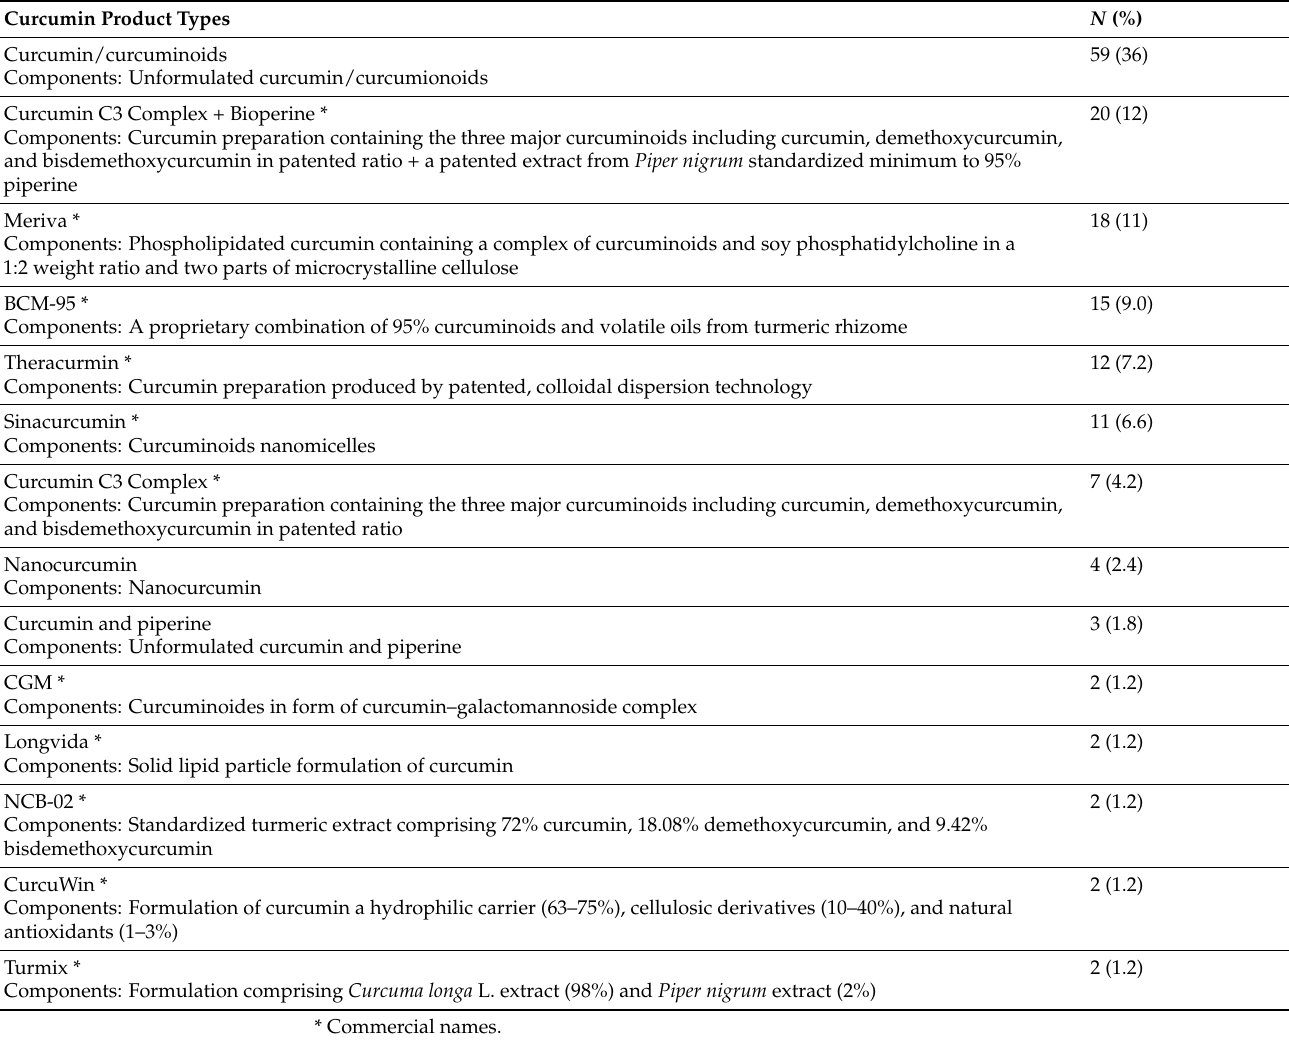
Table 2. The most common types of curcumin products used in analyzed trials ( N = 165); interventions used in two trials or more are shown. Commercial names of the products are marked with an